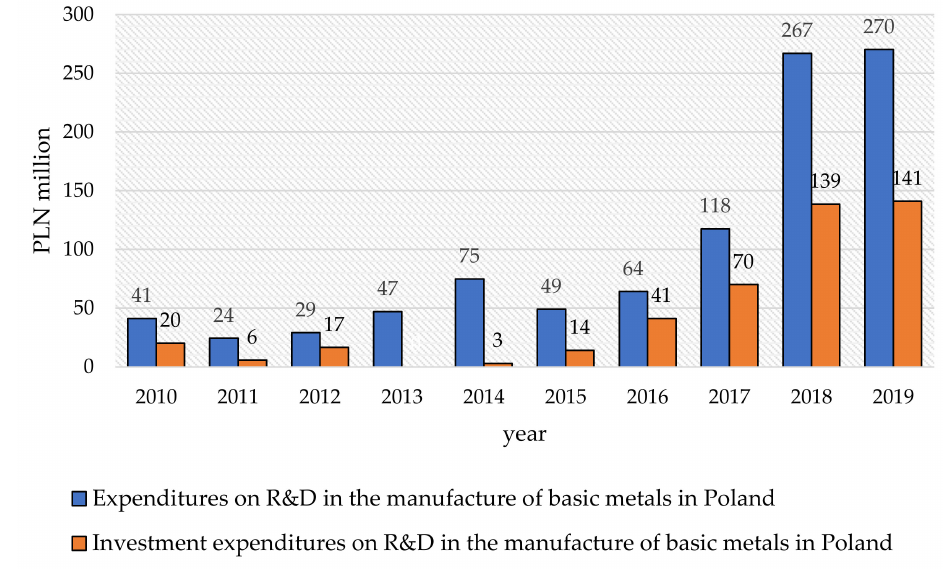
Figure 6. Investment expenditures on R&D in the manufacture of basic metals in Poland. Source: adapted with permission from Refs.